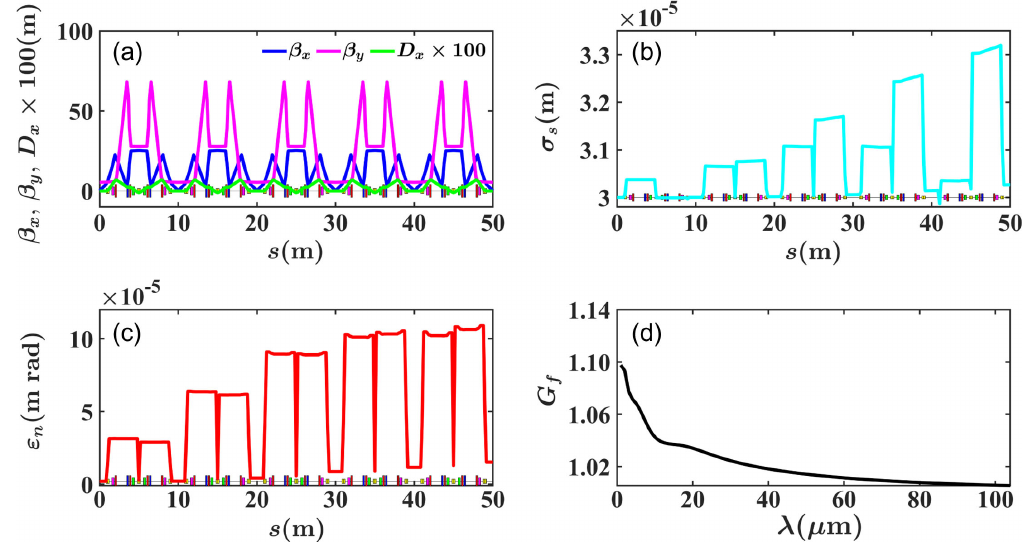
FIG. 11. Simulation results of five TBA cells: (a) optics functions; (b) the bunch length; (c) normalized transverse emittance; (d) the MBI